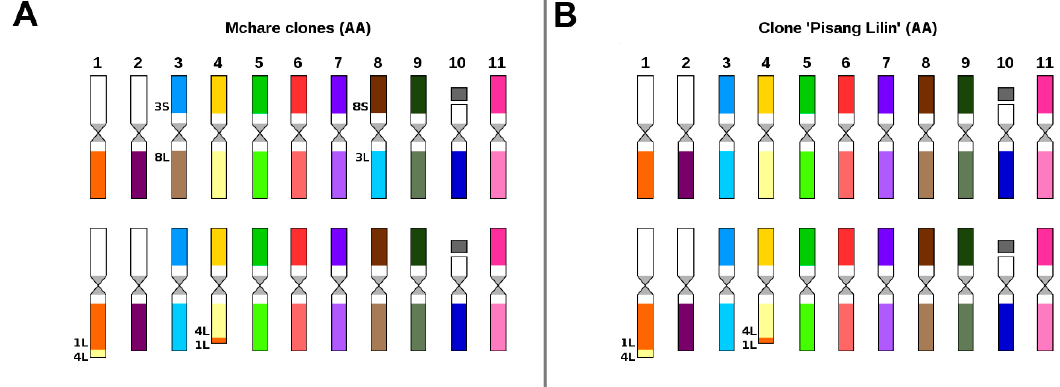
Figure 2. Ideograms of diploid (2n = 2x = 22) Musa clones: ( A ) M. acuminata subgr. Mchare, clones “Huti white”, “Huti (Shumba nyeelu)”, and “Ndyali”; ( B ) M. acuminata clone “Pisang Lilin”. Chromosome paints were not used for the short arms of chromosomes 1, 2, and 10. Chromosomes are oriented with their short arms on top and the long arms on the bottom in all ideograms. For better orientation, translocated parts of the chromosomes contain extra labels, which include chromosome number and the chromosome arm that was involved in the rearrangement.